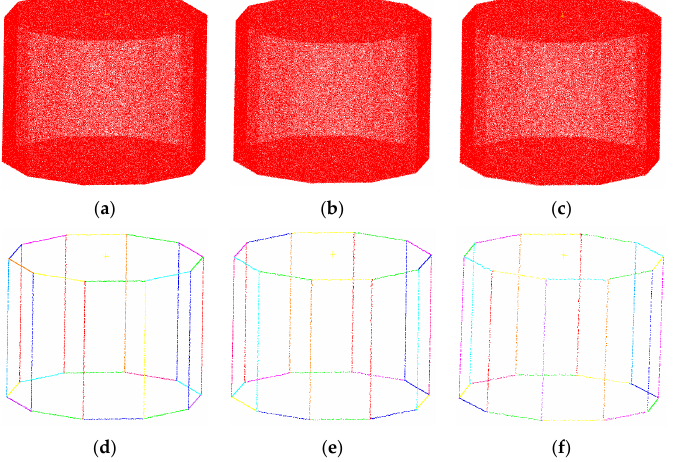
Figure 17. Three-dimensional line extraction effect under gaussian noise interference, from left to right are 0.01 m, 0.03 m, and 0.05 m Gaussian noise, respectively. ( a , b , c ) Input point clouds with Gaussian noise. ( d , e , f ) Extracted line segments. Gaussian noise. ( d , e , f ) Extracted line